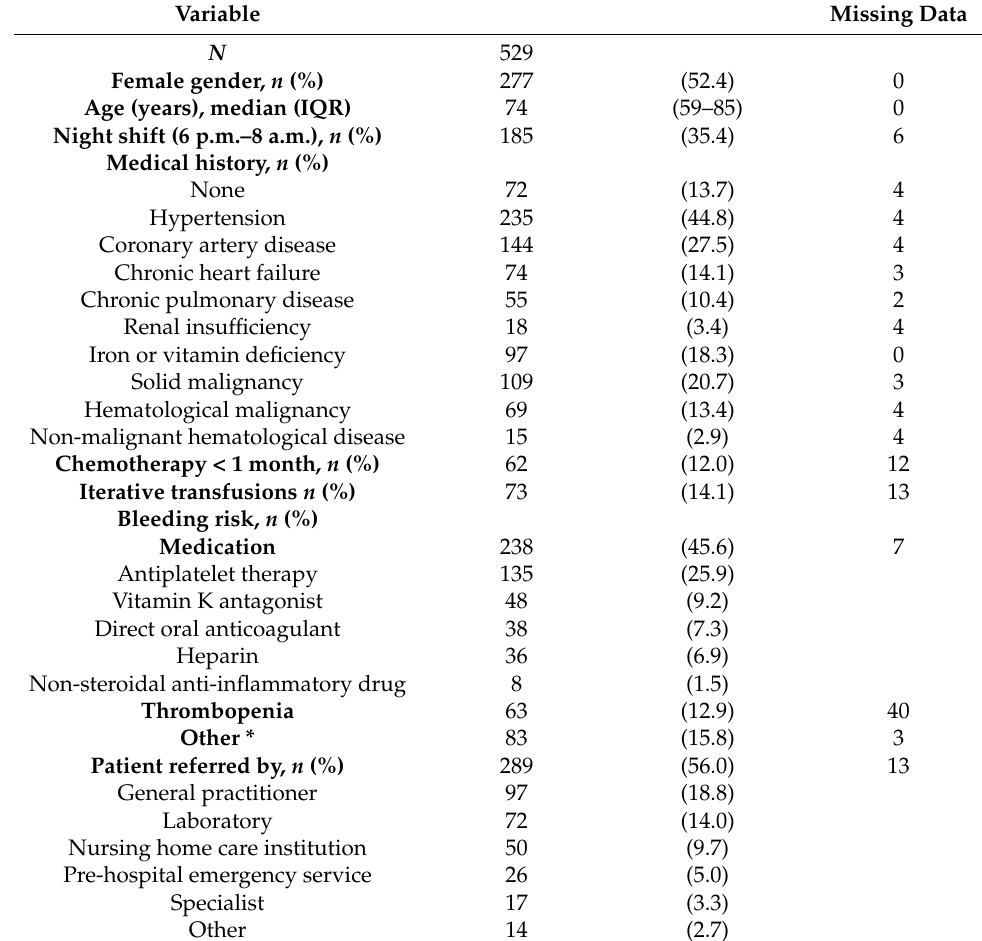
Table 1. General characteristics of patients transfused with red blood cells in the ED. Variable Missing